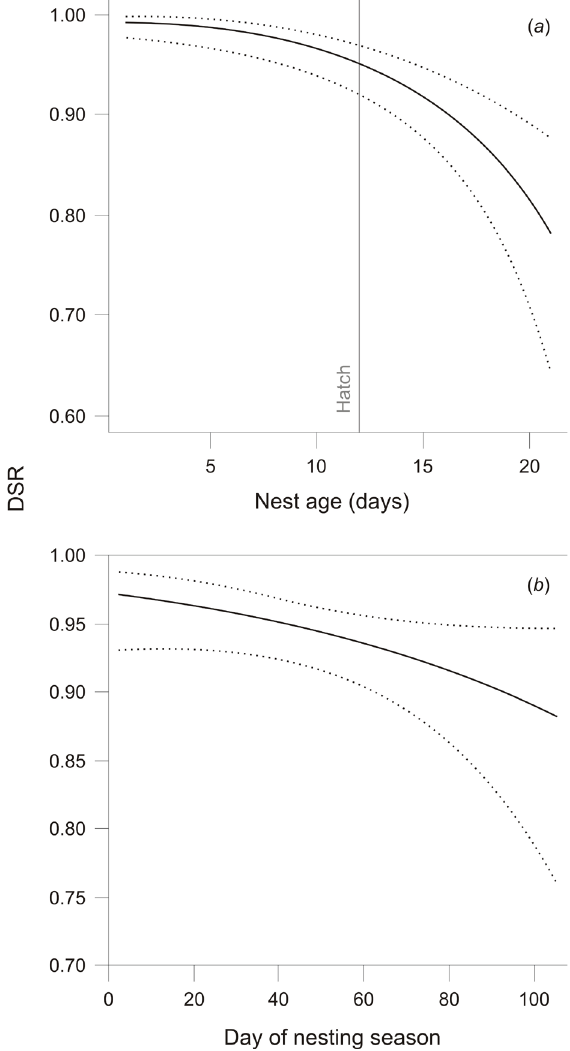
Figure 1. Estimated daily survival rates (DSR) of nests of the Tawny-bellied Seedeaters Sporophila hypoxanta during three breeding seasons (2007-2010), according to nest age (a; through the 21-days nesting cycle: 12 of incubation and 9 of nestling) and day of nesting season (b; respecting a linear time trend), calculated with program MARK by means of candidate models that include each predictor variable. Dashed lines represent 95% confidence